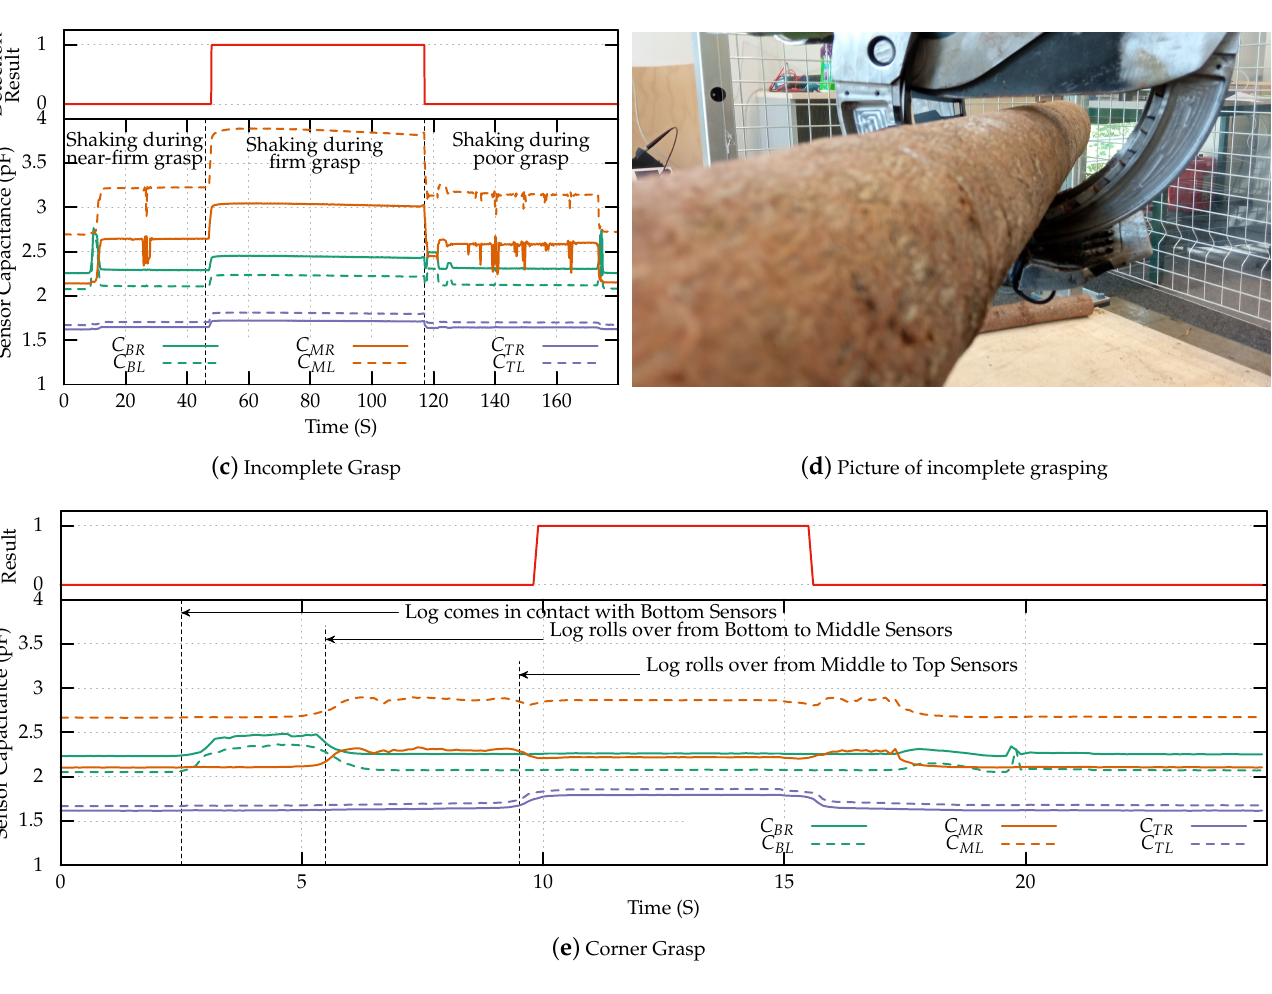
Figure 8. Experimental results for grasping medium (7.5cm) log. The solid lines represent the electrodes on the right claw and dashed lines represent the electrodes on the left claw. The result of detection algorithm is plotted in red on top of each plot. ( a ) shows the output of the sensors during a proper firm grasp, ( b ) shows the output of the sensors when grasping the log in the corner and ( c ) shows the output of the sensors when moving the log under incomplete grasp, ( d ) shows a picture of incomplete grasping procedure and ( e ) shows the results of grasp detection for small